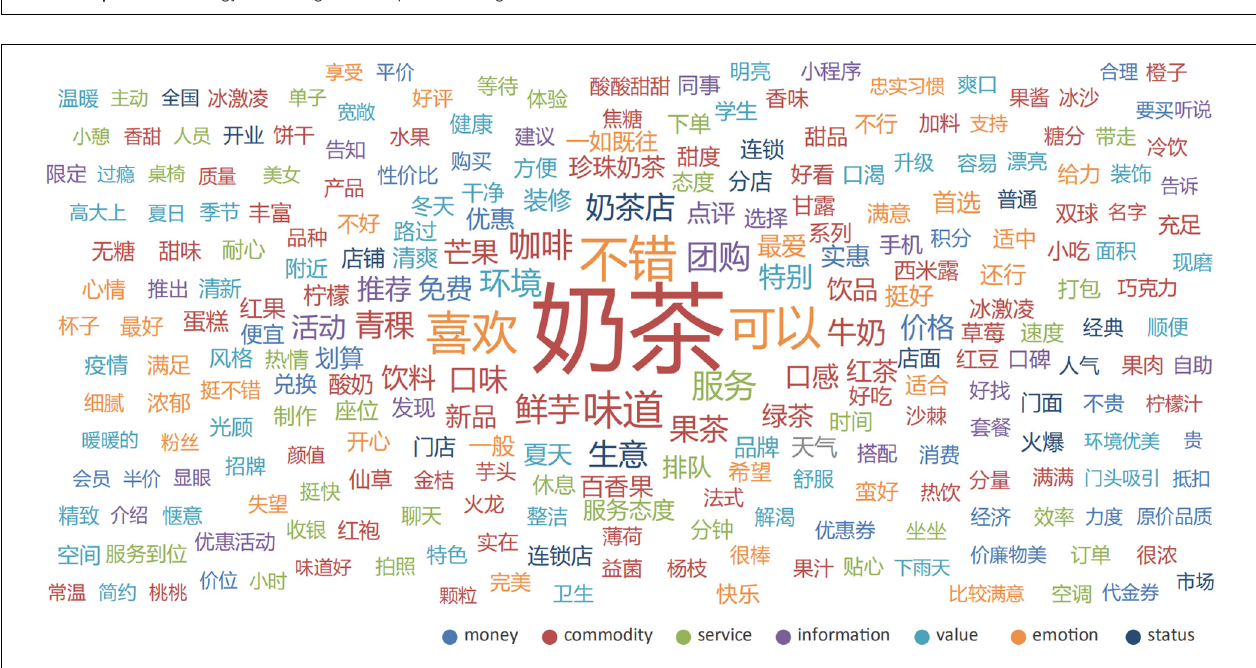
FIGURE 7 | Domain ontology of beverage consumption exchange element.